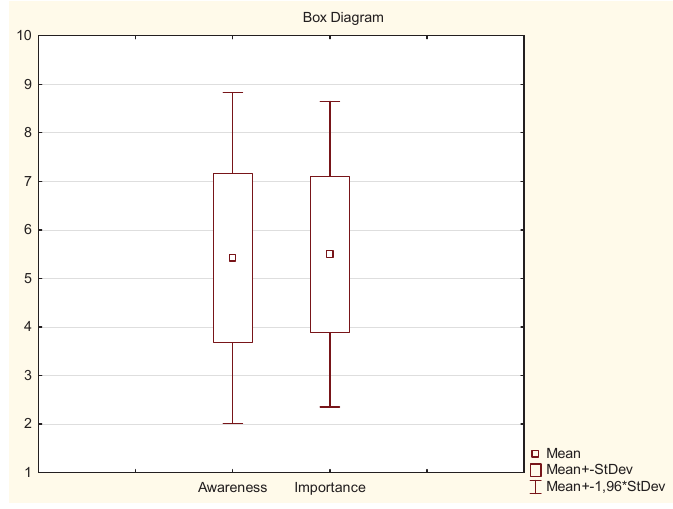
Fig. 2 – The Box Diagram of answers related to Awareness and Importance questions. Source: Own processing at STATISTICA, 2015